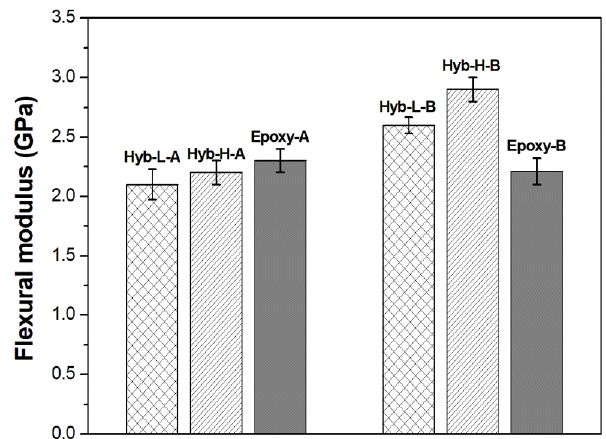
Figure 11. Flexural modulus of hybrid and non-hybrid epoxy systems. Polymers 2018 , 10 , x FOR PEER REVIEW